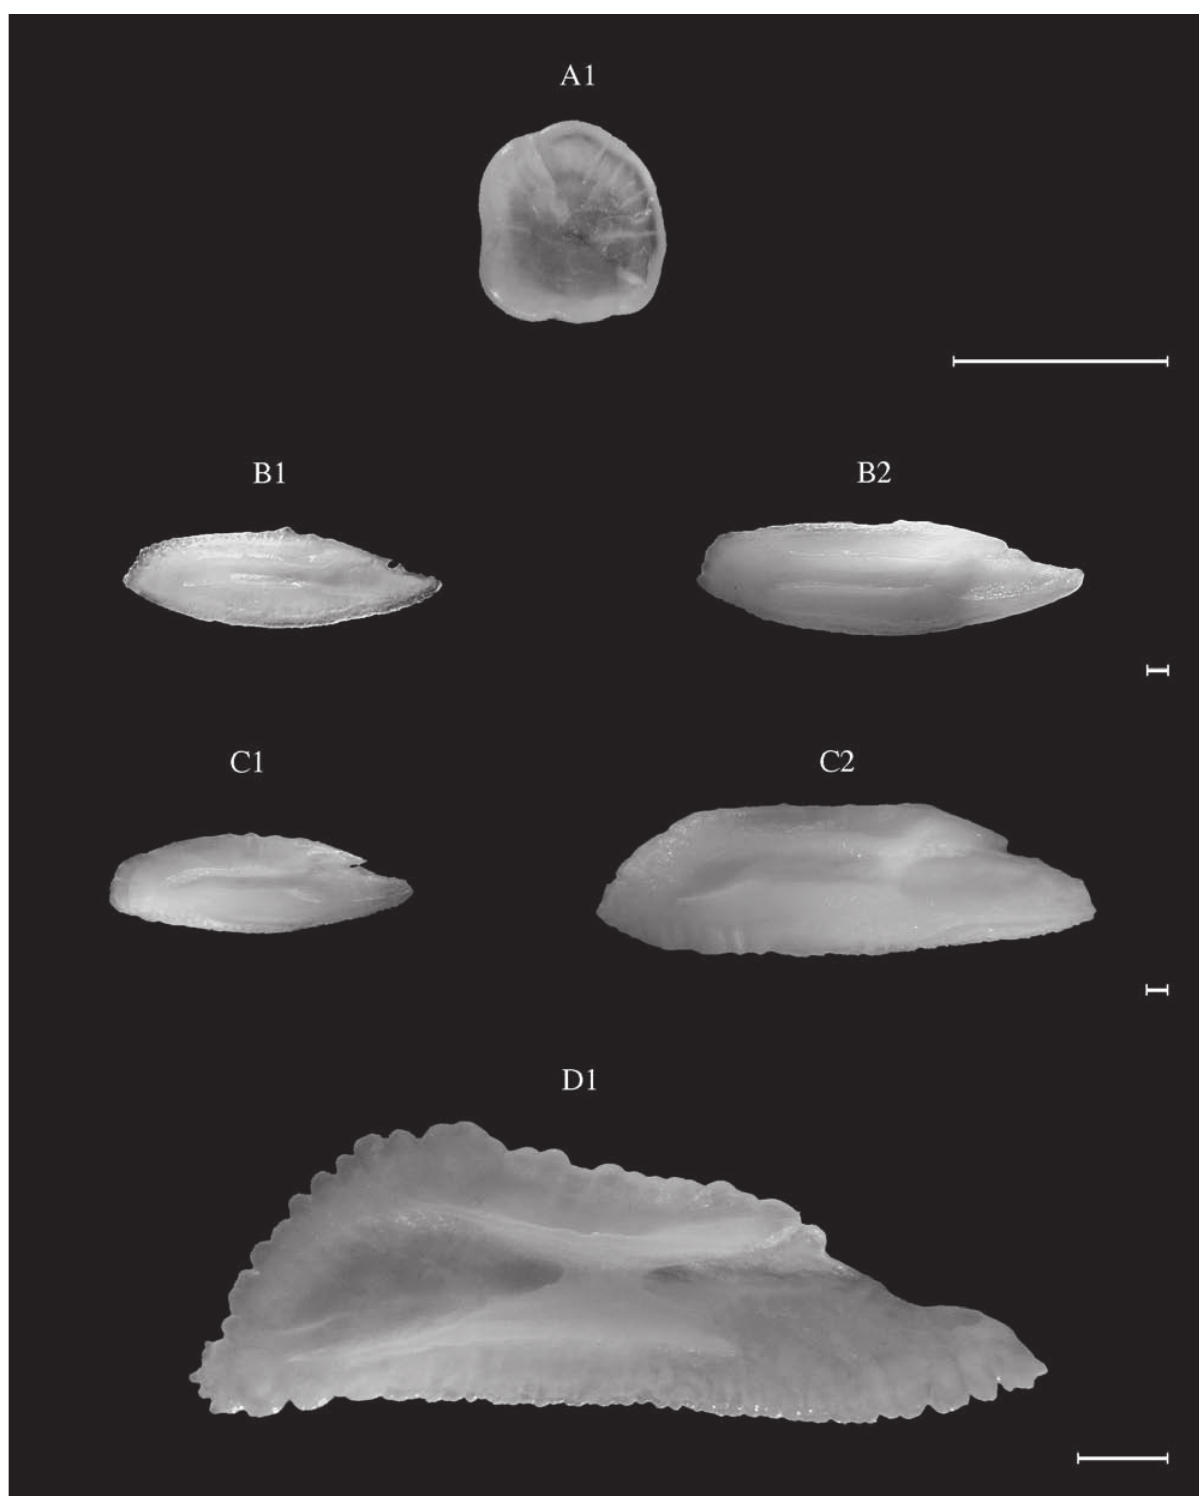
Fig. 82. – Pseudaphya ferreri (WM). TL: A1, 3.2 cm. Sphyraena sphyraena (WM). TL: B1, 32.7 cm; B2, 42.7 cm. Sphyraena viridensis (CEA). TL: C1, 57.0 cm; C2, 108.0 cm. Lepidocybium flavobrunneum (CEA). TL: D1, 94.0 cm. Scale bar = 1